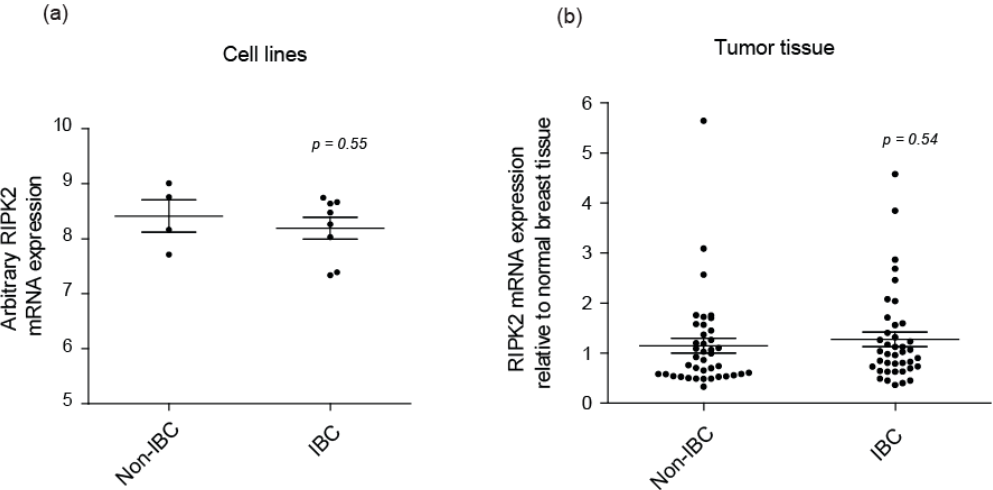
Figure 6. Total RIPK2 mRNA expression in Non-IBC and IBC: ( a ) cell lines ( n = 12) GEO (Gene Expression Omnibus dataset) (GSE40464) [62] and ( b ) tumor tissue ( n = 40) GEO dataset (GSE45584) [63] from public breast cancer expression array datasets. IBC cell lines include MDA-IBC-3, MDA-IBC-2, SUM149, and SUM190, non-IBC includes MDA-MB-231, MDA-MB-468. In ( b ) Non-IBC mainly refers to Luminal A, Luminal B, HER2 overexpressed, and TNBC.